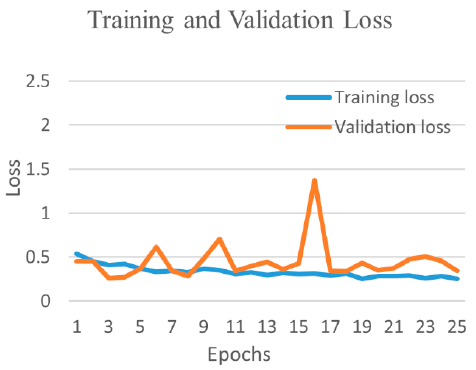
Figure 20. Training and validation loss of best performing VGG16 model for five-class.